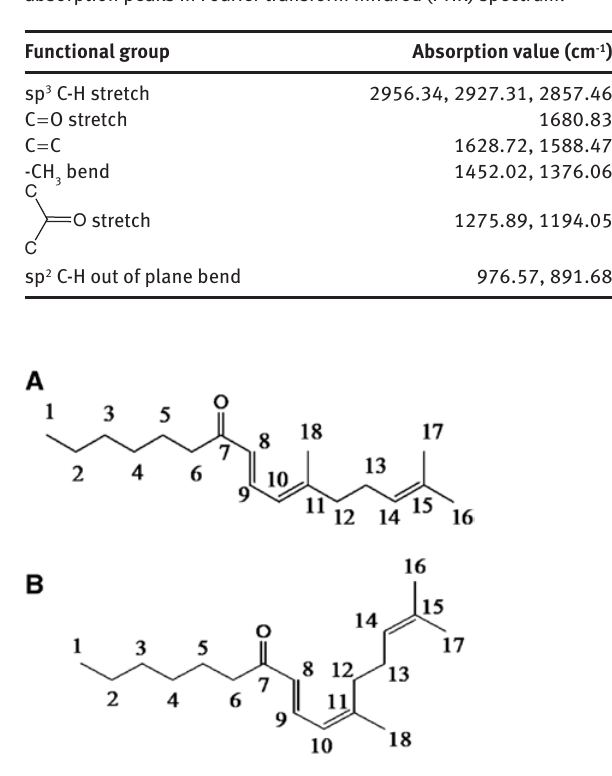
Table 5: 11,15-Dimethyl-hexadeca-8,10,14-trien-7-one isomers absorption peaks in Fourier transform infrared (FTIR) spectrum.